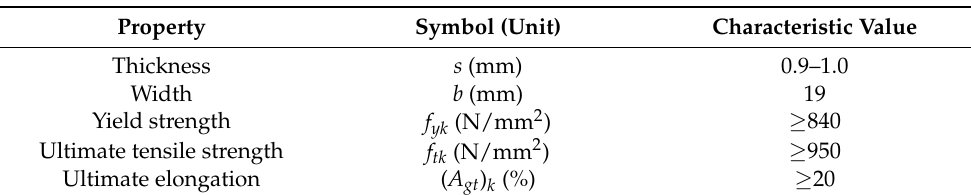
Table 1. Mechanical properties of CAM ® stainless-steel strips.